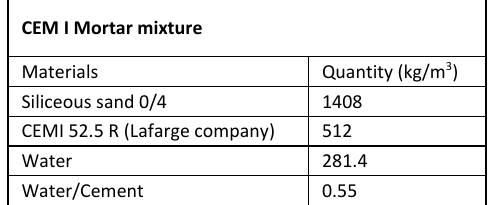
Table 2. Mortar formulation.